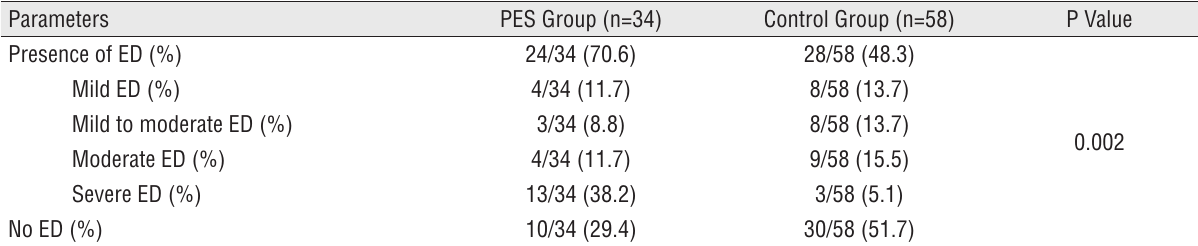
Table 2 - Comparison of two groups for presence of ED and severity.